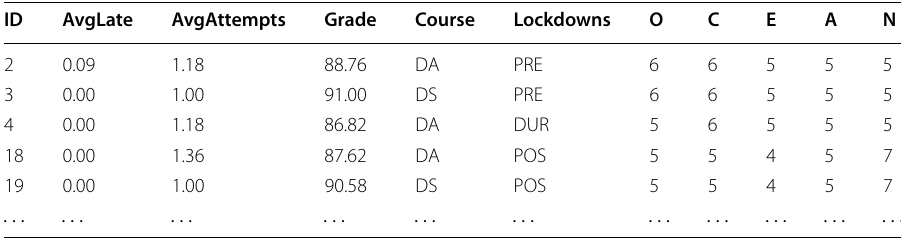
Table 4 Example of data records in matched